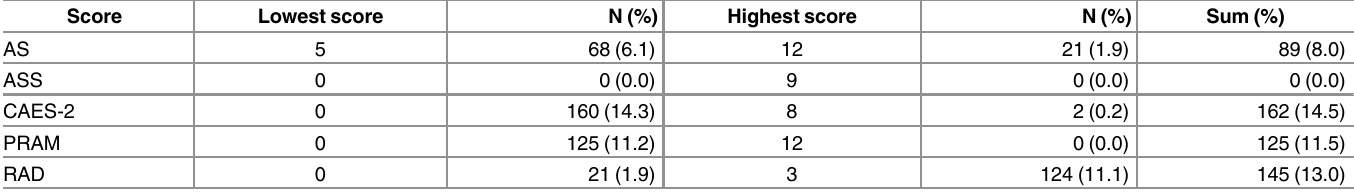
Table 6. Floor and ceiling scores and percentages in five dyspnoea